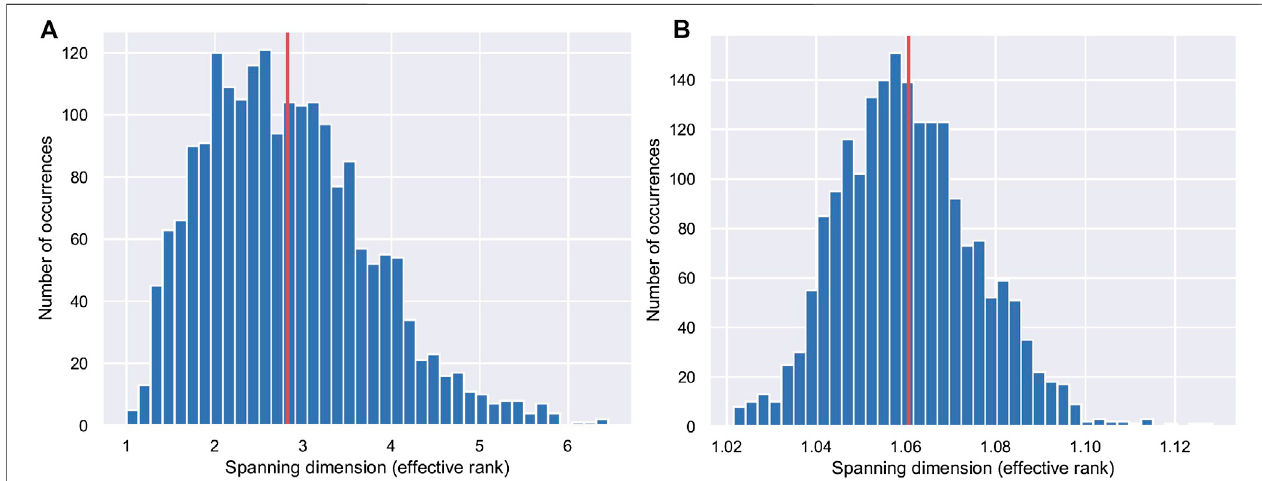
FIGURE 2 | Estimated spanning dimension distribution (effective rank) with 2,000 samples of a neural network with f ( z ) (cid:2) z 2 activation functions, one node per hidden layer, one input, one output, and two hidden layers with expected spanning dimension